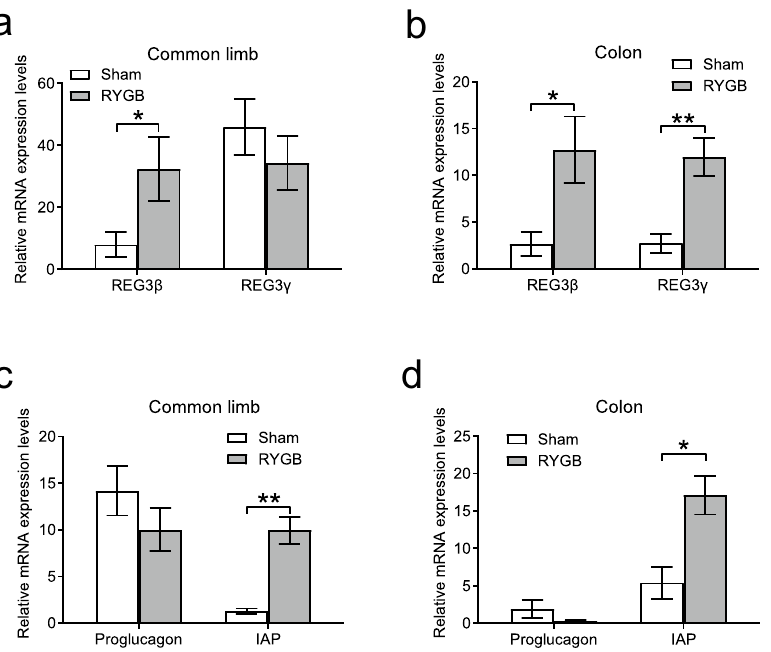
Figure 5. The production of intestinal antimicrobial peptides and IAP was enhanced after RYGB. ( a , b ) The mRNA levels of REG3β were significantly upregulated in both the common limb and colon of mice in the RYGB group ( n = 5/group) compared to the sham group ( n = 6/group), and the mRNA expression level of REG3γ was increased in the colon of the RYGB group. ( c , d ) The mRNA expression level of IAP, but not proglucagon, was significantly increased in both the common limb and colon. REG3β regenerating islet-derived-3 beta, REG3γ regenerating islet-derived-3 gamma, IAP intestinal alkaline phosphatase. All data are the mean ± SEM. * p < 0.05; ** p <